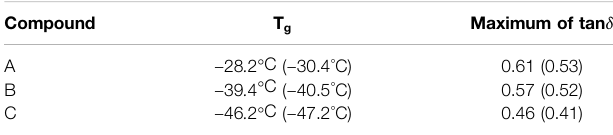
TABLE 1 | Summary of the glass transition temperatures of the A, B and C compounds. The glass transition temperature is de fi ned as the maximum of tan δ asafunctionoftemperatureforthefrequency ω 0 (cid:1) 0 . 01s − 1 .Thevaluesinthe parenthesis are from measurements performed one year earlier on nominally identical rubber compounds from a different batch (Tolpekina and Persson, 2019).